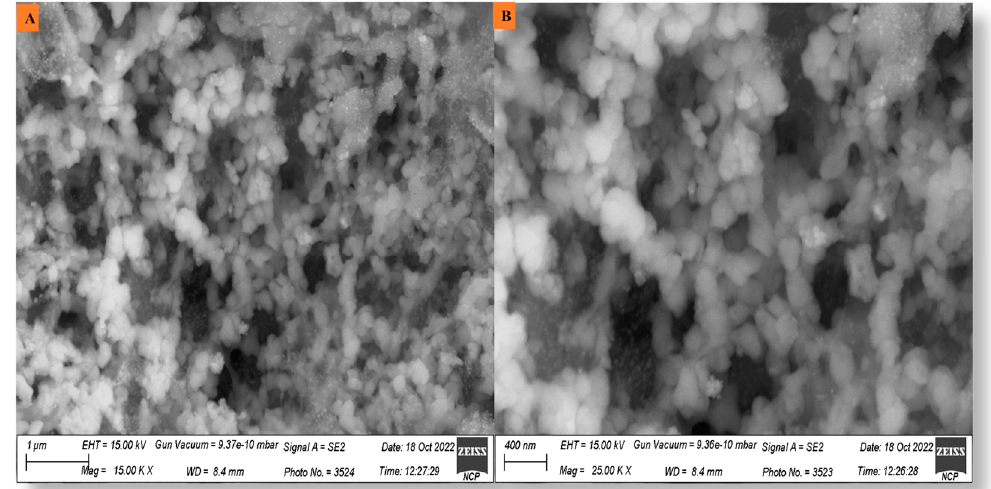
Figure 6. ( A ) and ( B ) SEM analysis of biogenic P . alsinaefolia -mediated Ag 2 ONPs determining the topology of Ag 2 ONPs. topology of Ag 2